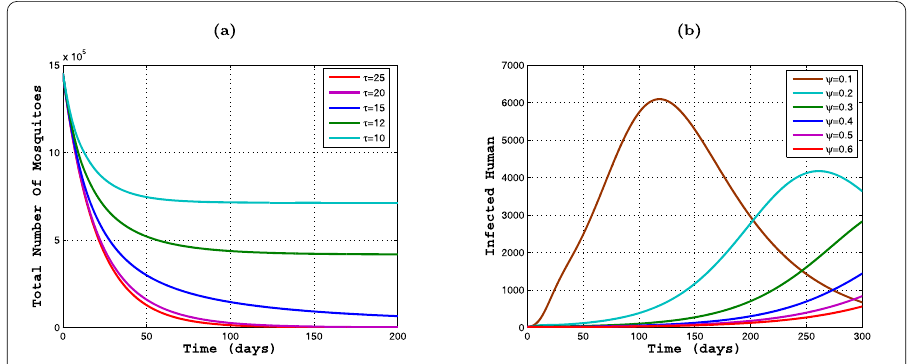
Figure 5 The influences of the maturation delay and the vaccinated fraction to eliminate Dengue: (a) b = 1, τ = 25, 20, 15, 12, and 10; (b) τ = 5, b = 1, ψ = 0.1, 0.2, 0.3, 0.4, 0.5, and 0.6.